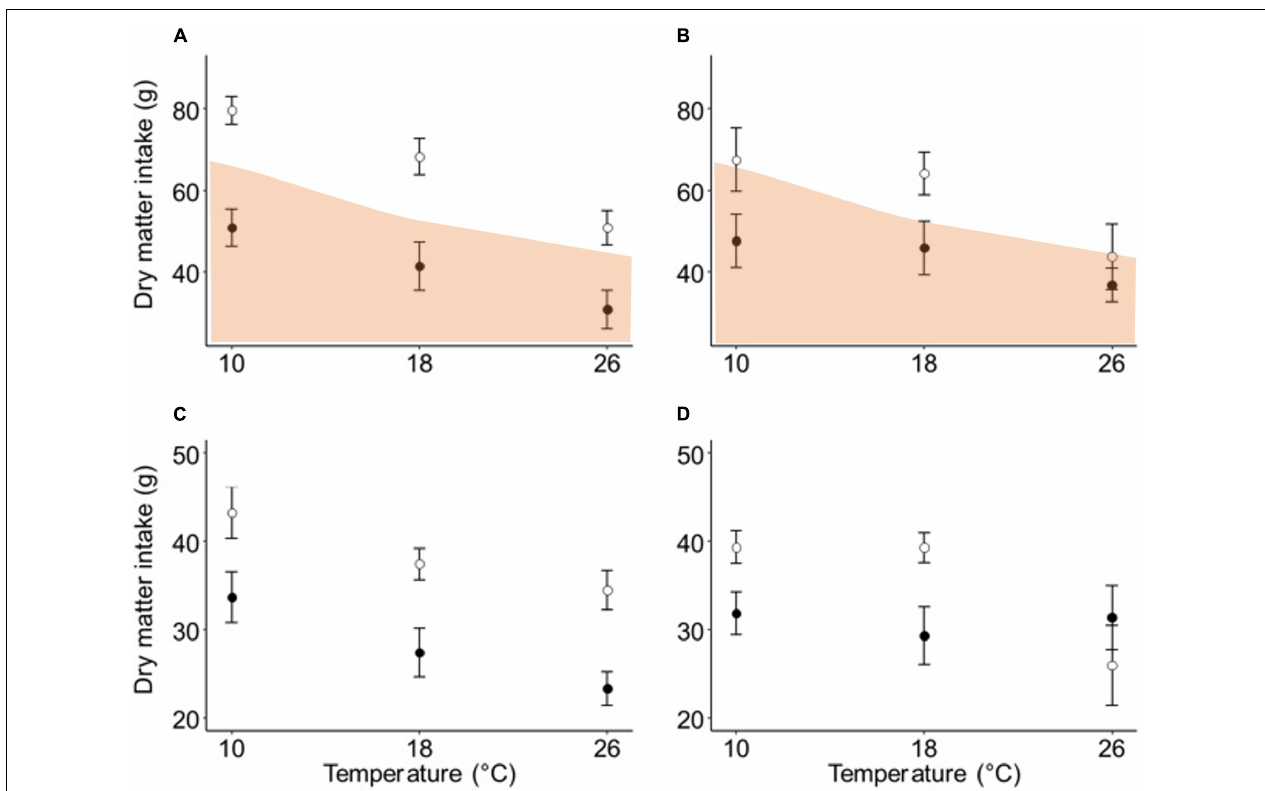
FIGURE 3 | The effect of (A) week-long exposure, and (B) < 24 h exposure to three ambient temperatures on the mean ( ± SE) food intake of brushtail possums ( n = 12) offered a diet with (filled) or without (unfilled) flavanone. An estimate of minimum daily energy requirements (Cooper et al., 2018) is shown in orange. The effect of (C) week-long exposure, and (D) < 24 h exposure to three ambient temperatures on the mean ( ± SE) food intake of ringtail possums ( n = 12) offered Eucalyptus melliodora foliage with a high (filled) or low (unfilled) concentration of